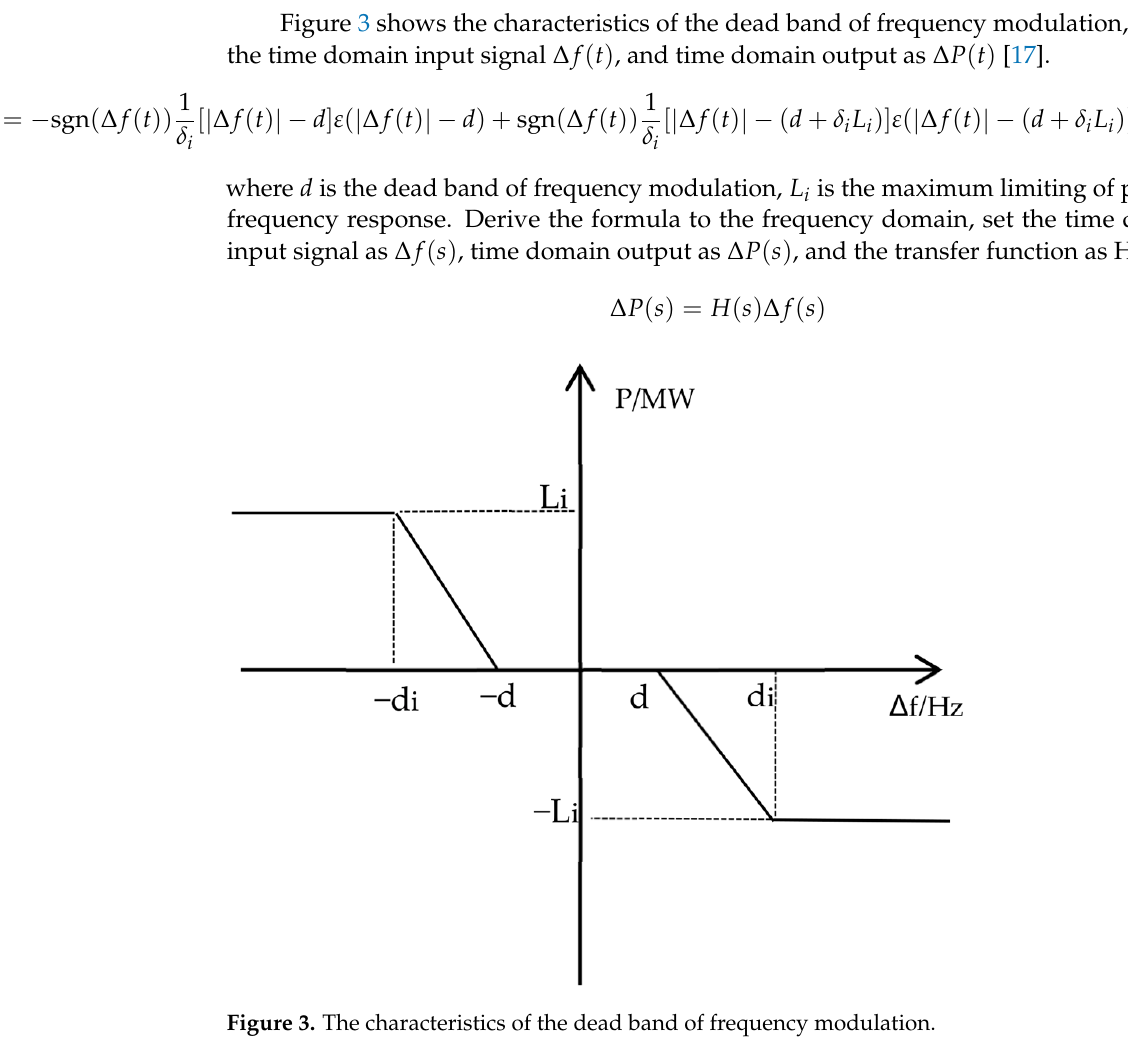
Figure 3. The characteristics of the dead band of frequency modulation.